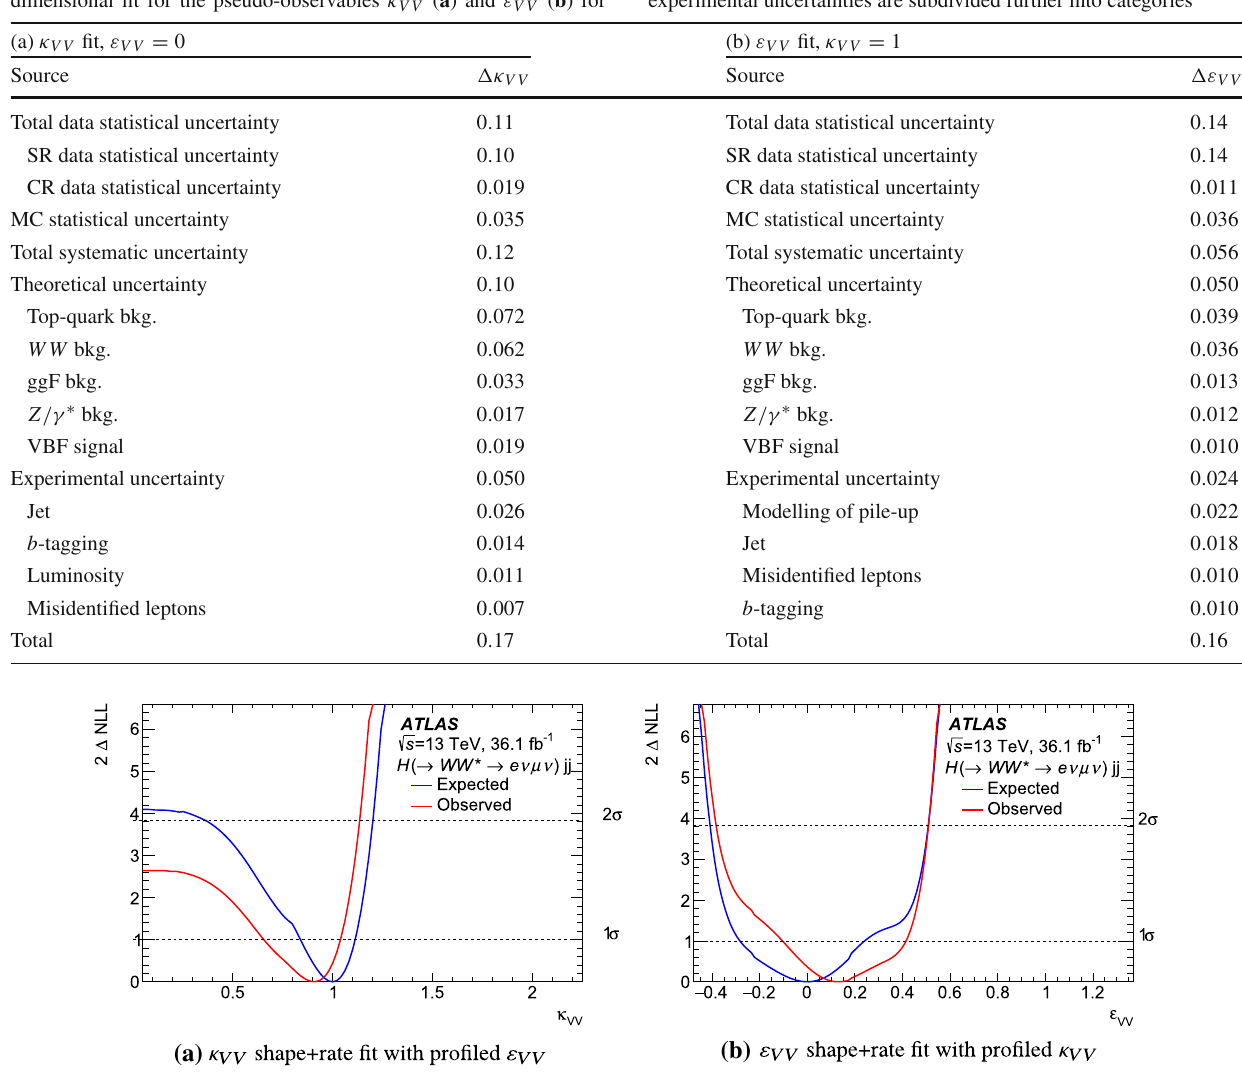
Table 11 The contributions of the leading individual systematic uncer- tainties together with the data statistical uncertainties, in the one- dimensional fit for the pseudo-observables κ VV ( a ) and ε VV ( b ) for